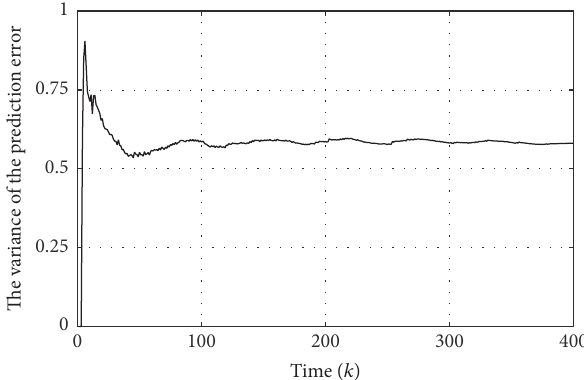
Figure 6: Evolution curve of the variance of the prediction error 𝜎 2 (𝑘) 𝜀